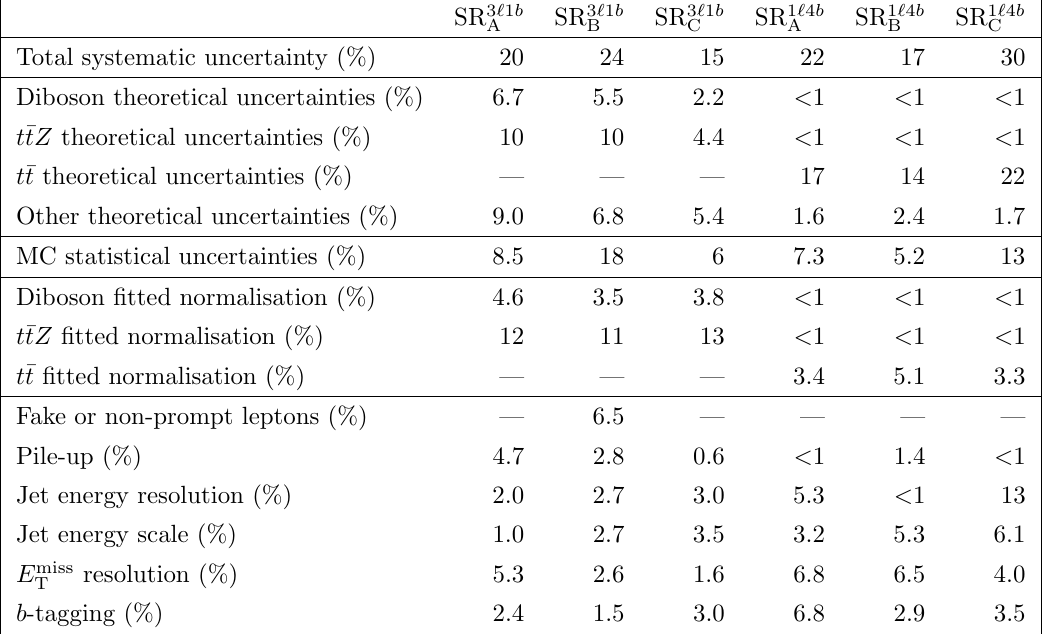
Table 8. Summary of the main systematic uncertainties and their impact (in %) on the total SM background prediction in each of the signal regions studied. The total systematic uncertainty can be di(cid:11)erent from the sum in quadrature of individual sources due to the correlations between them resulting from the (cid:12)t to the data. The quoted theoretical uncertainties include modelling and cross-section